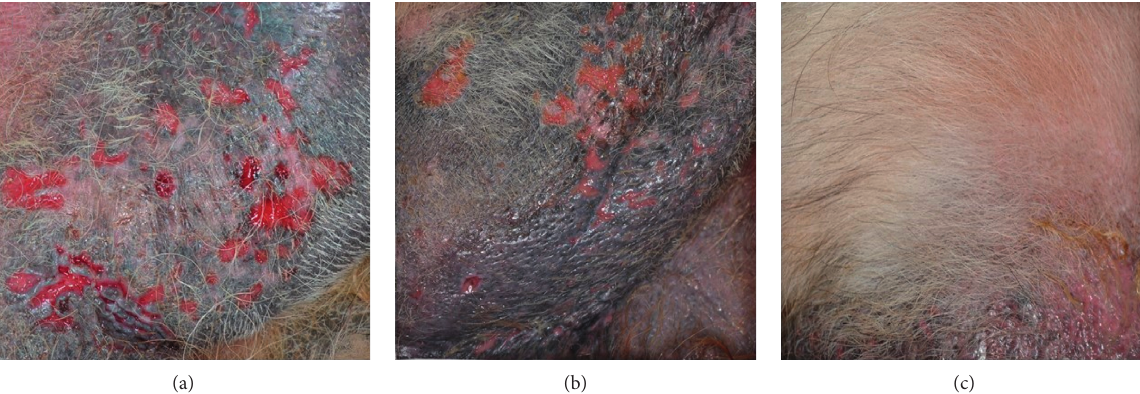
Figure 1: Group B case #8 clinical evaluation visit pictures. (a) Enrolment visit; (b) day 21 visit; (c) day 42 visit; clinical resolution was